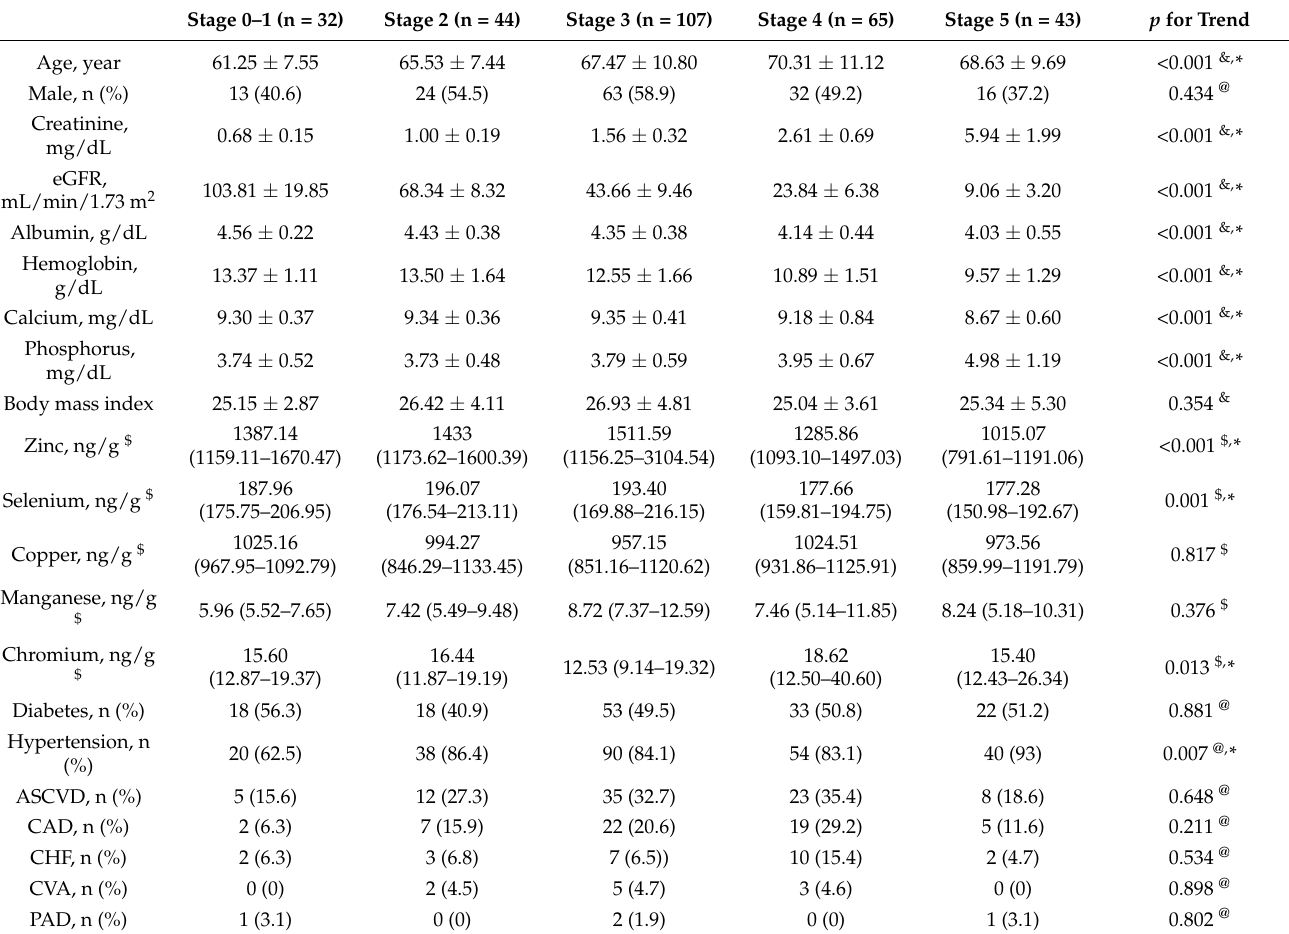
Table 2. Demographics and clinical characteristics among various CKD